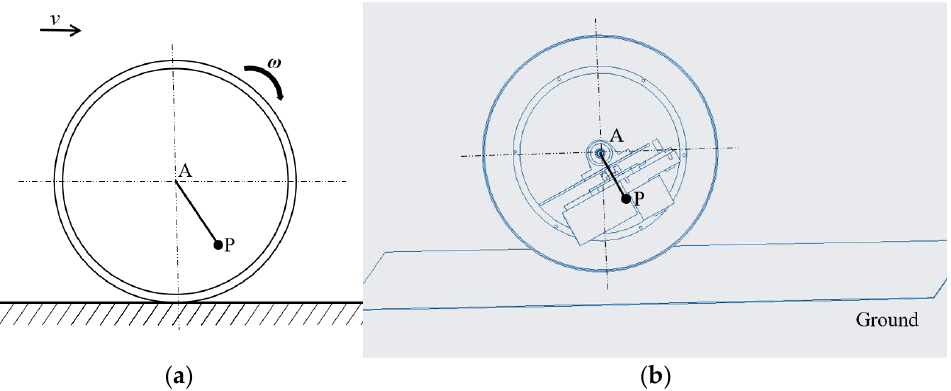
Figure 3. ( a ) The simplified model of the single pendulum-driven rolling robot; ( b ) The schematic diagram of the counterweight position in rolling motion.